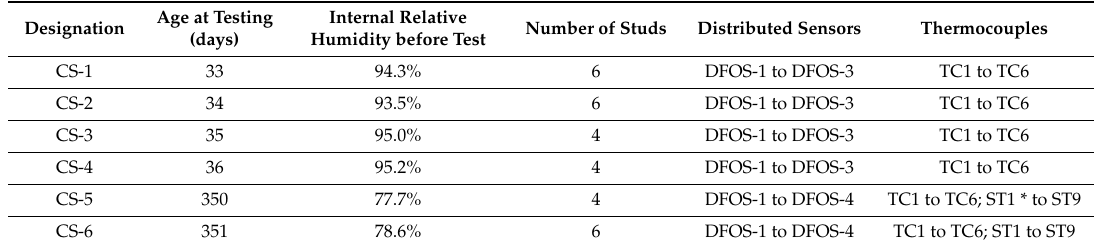
Table 1. Details of the composite